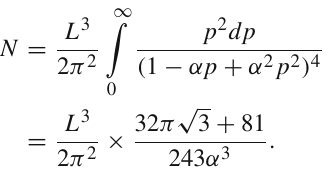
modes for massless bosonic field in a cubic box (with D =